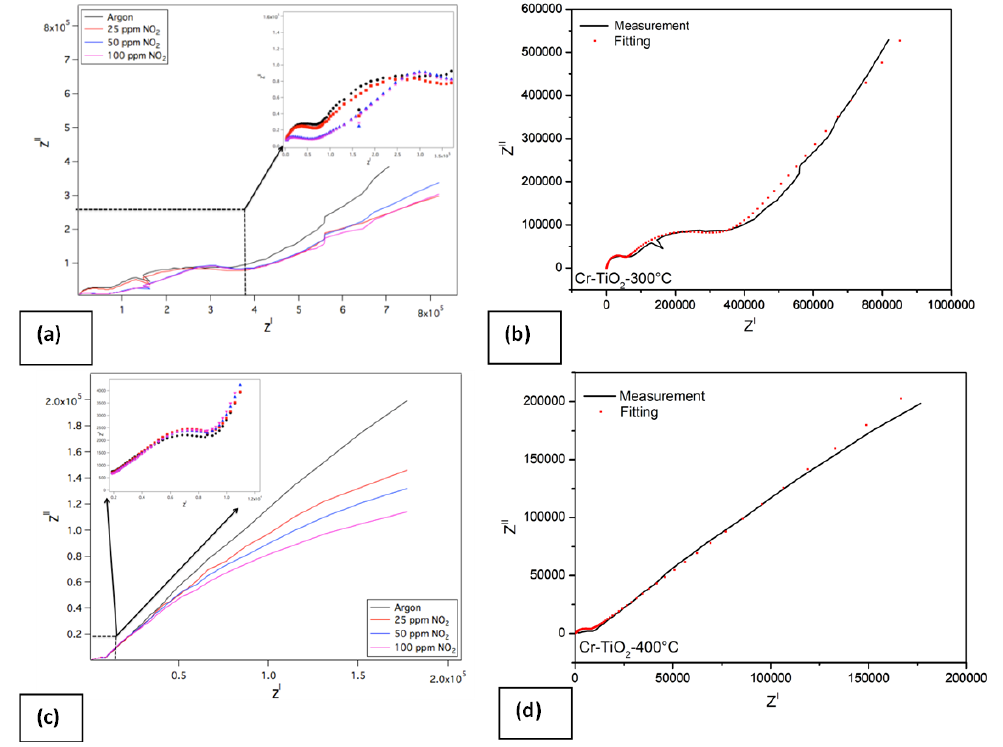
Figure 13. Impedance spectra of Cr doped TiO NO at 300 °C ( a ) measurement results ( b ) fitting result combined with measurement and 2 at 400 °C ( c ) measurements ( d ) fitting result combined with